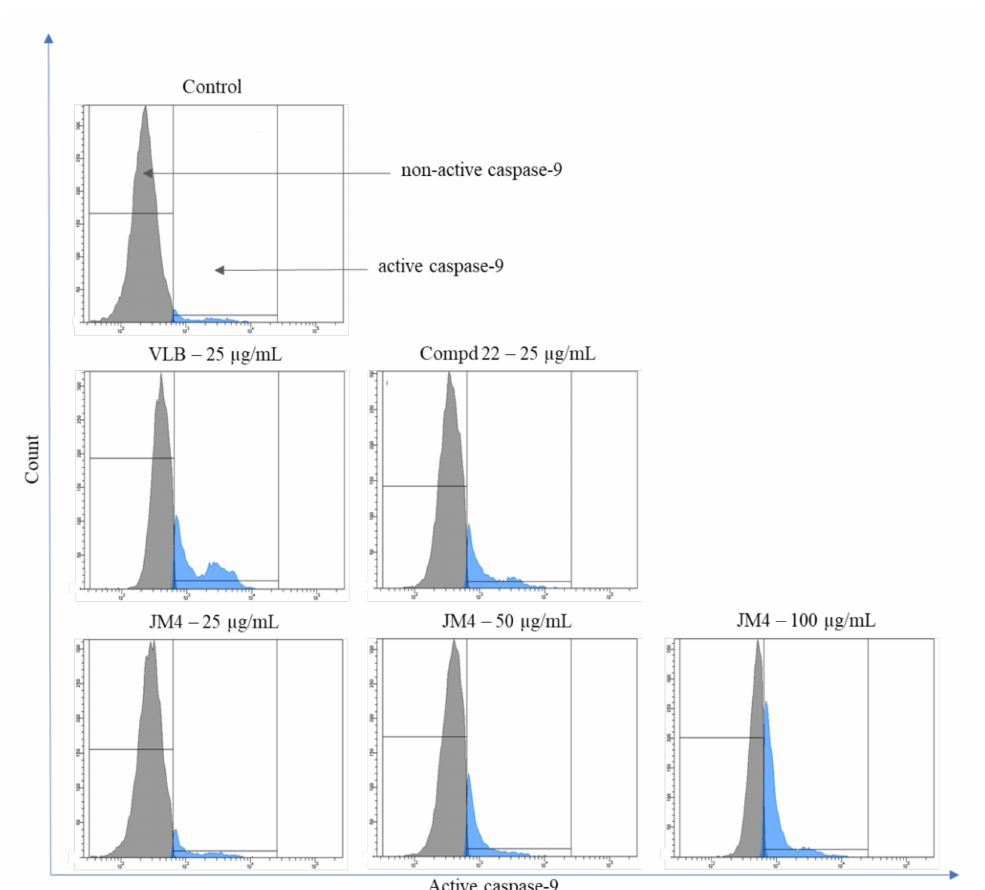
Figure 15. Flow cytometric analysis of populations C32 melanoma cells treated for 24 h with JM4 (25, 50, 100 µ g/mL), 22 (25 µ g/mL) and vinblastine sulfate (VLB) (25 µ g/mL) for active caspase-9.